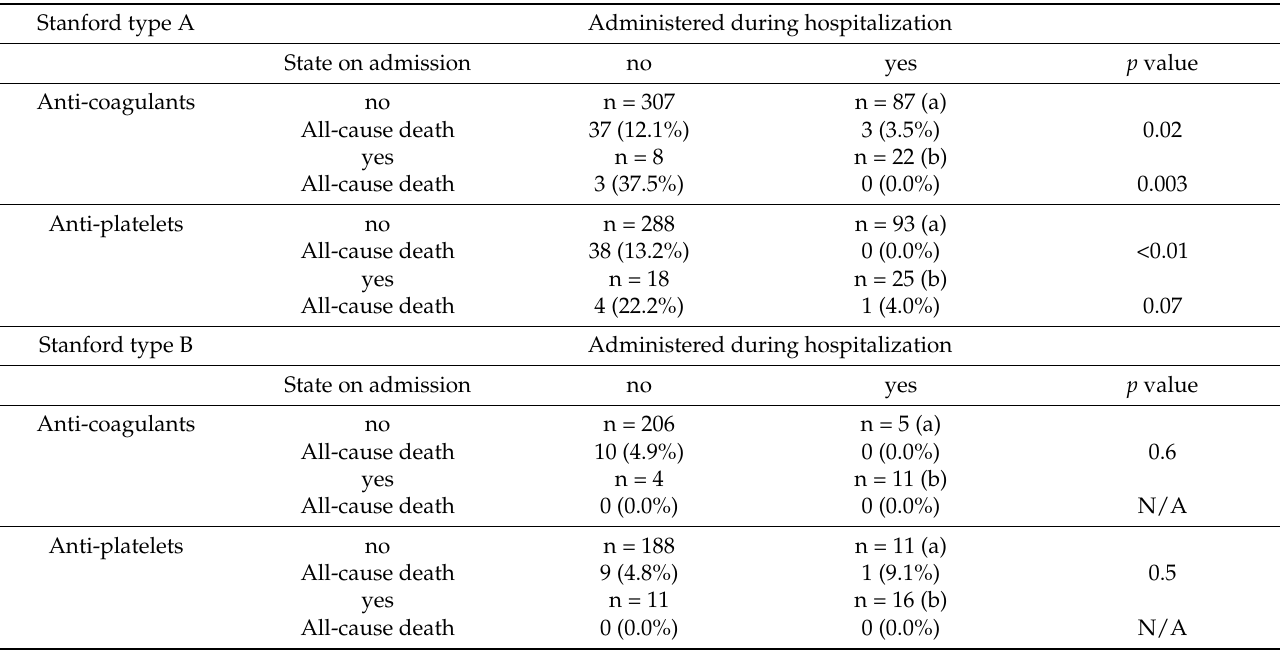
Table 11. All-cause death of anti-thrombotic agents administered during hospitalization in HOSPI- TALIZED